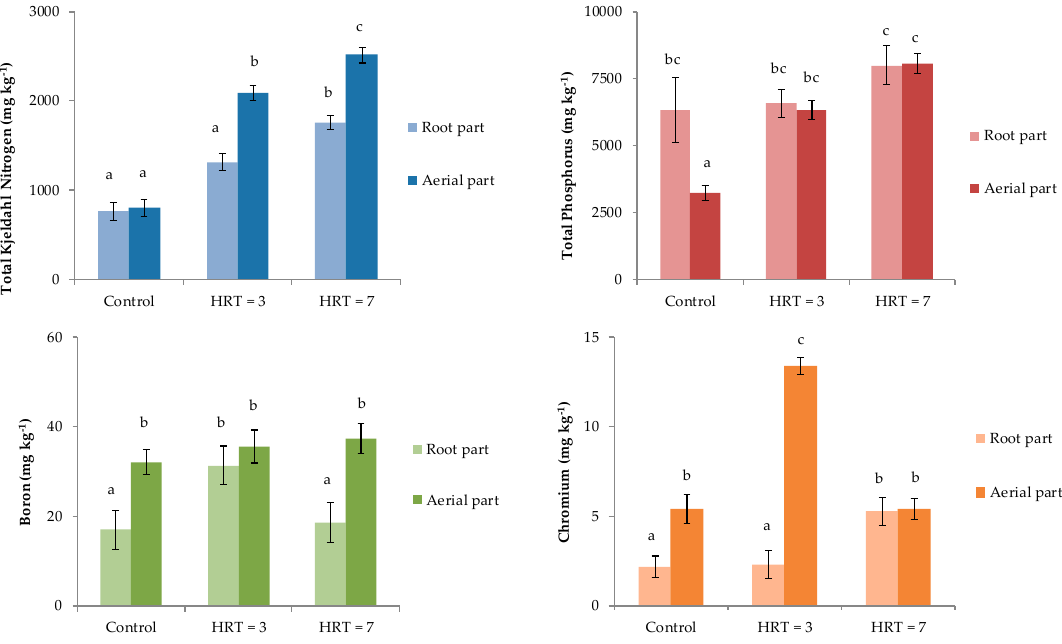
Figure 2. Concentrations of TKN, TP, B, and Cr in aerial part and roots of P. australis .